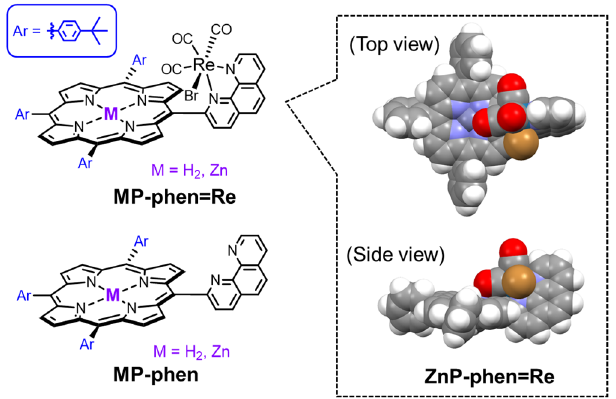
Figure 6. (Left) Chemical structures of the porphyrin–Re complex dyads with direct and orthogonal binding ( MP-phen=Re ) and the corresponding porphyrins ( MP-phen ). (Right) Molecular model of ZnP-phen=Re optimized using a density functional theory calculation [43,44].